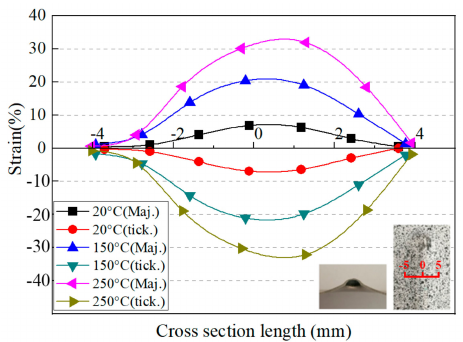
Figure 8. Major strain and thickness strain map along the investigated cross